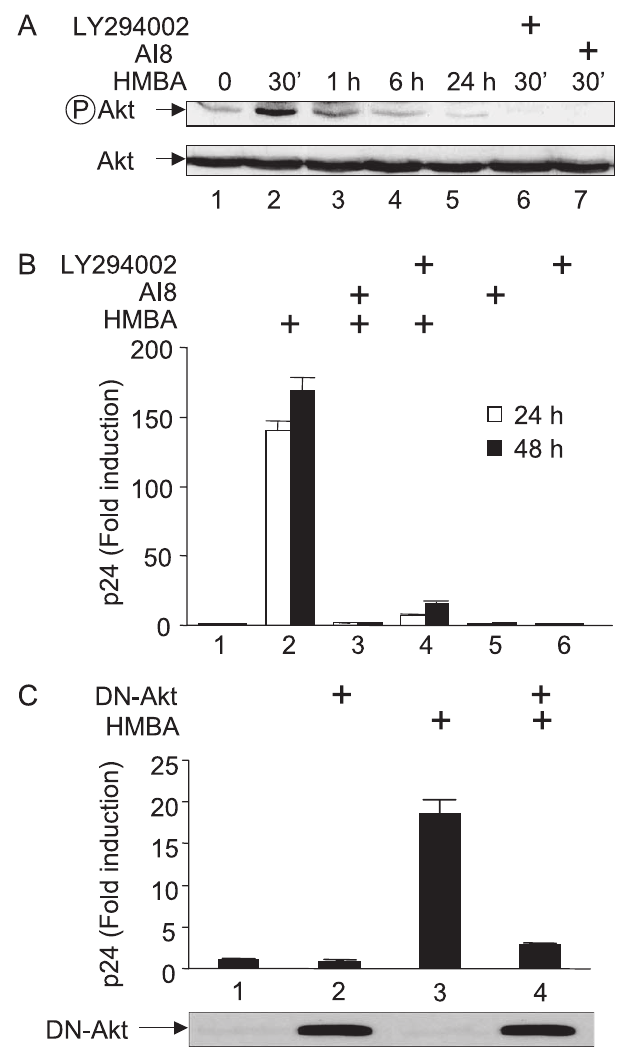
Figure 2. HMBA Induces HIV Production from Latently Infected Cell Lines via the PI3K/Akt Pathway (A) Total cell lysates of Jurkat cells preincubated or not with inhibitors of Akt or PI3K (AI8 or LY294002) and stimulated or not by HMBA (5 mM) for 30 min, 1 h, 6 h, and 24 h were analyzed by western blotting using anti- phospho-Akt antibodies, or Anti-Akt antibodies for loading controls. (B) U1 cells were cultured in the presence or absence of LY294002 (10 l M) or AI8 (1 l M) prior to stimulation with HMBA (5 mM). Concentrations of p24 antigens were then measured from supernatants at 24 and 48 h after stimulation to assess viral production. (C) U1 cells were transfected with a plasmid expressing a dominant negative mutant Akt protein (DN-Akt) or with an empty plasmid vector. After 24 h, cells were stimulated or not with HMBA (5 mM) and viruses in the supernatant were quantified 24 h later using p24 ELISA. Lower panels represent the levels of DN-Akt expressed in cells as assessed using glu- glu tag